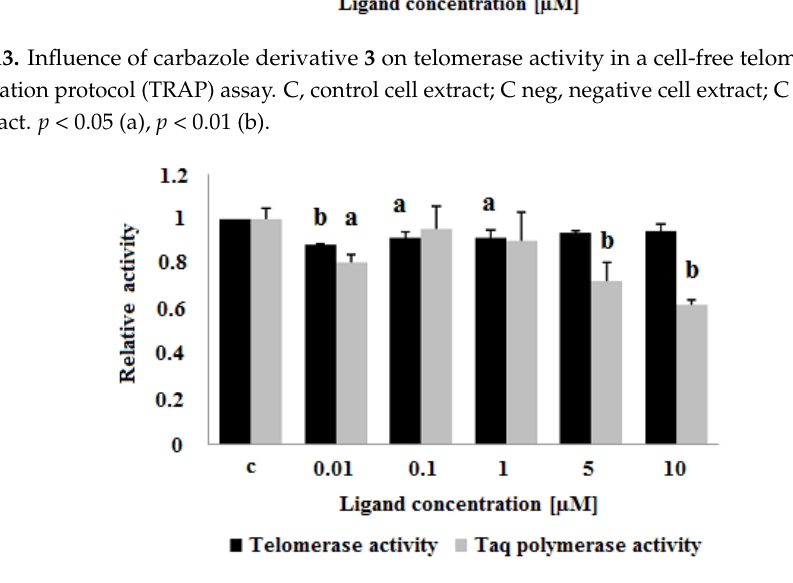
Figure 14. Influence of carbazole derivative 3 on telomerase activity in a cell-free TRAP assay and on Taq polymerase activity. C, control cell extract. p < 0.05 (a), p < 0.01 (b).